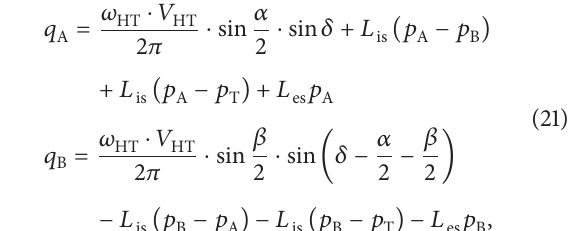
(𝑛 , Δ𝑝,𝑉 ) when Δ𝑝 = 𝑝 𝑖 T